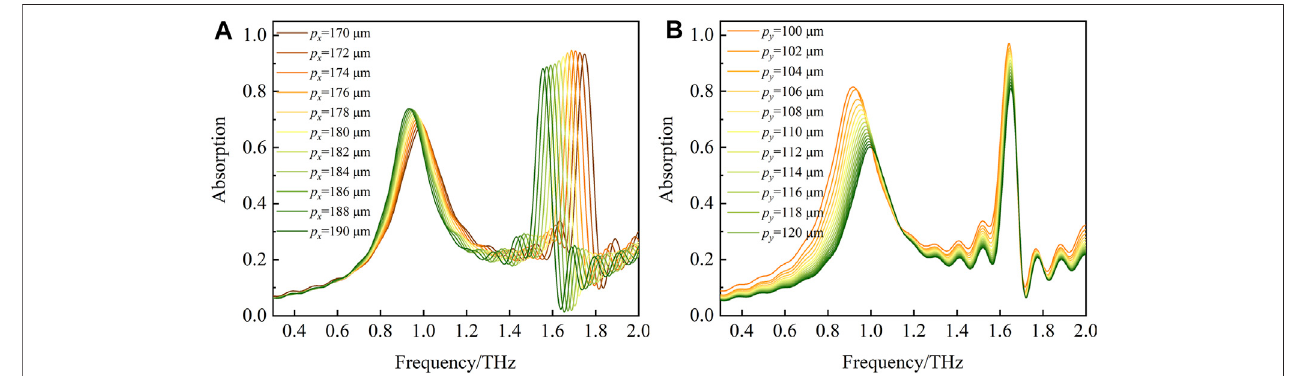
FIGURE 4 | (A) The absorption spectra of the CMMC with p x increasing from 170 to 190 μ m, where the p y is fi xed at 110 μ m. (B) The absorption spectra of the CMMC with p y increasing from 100 to 120 μ m, where the p x is fi xed at 180 μ m.